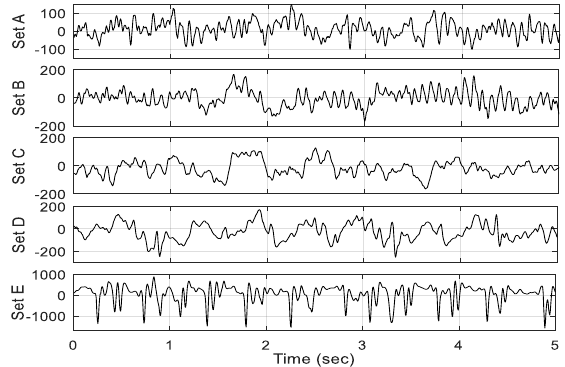
Figure 1. Electroencephalography (EEG) subframes selected from each of five sets (A–E).